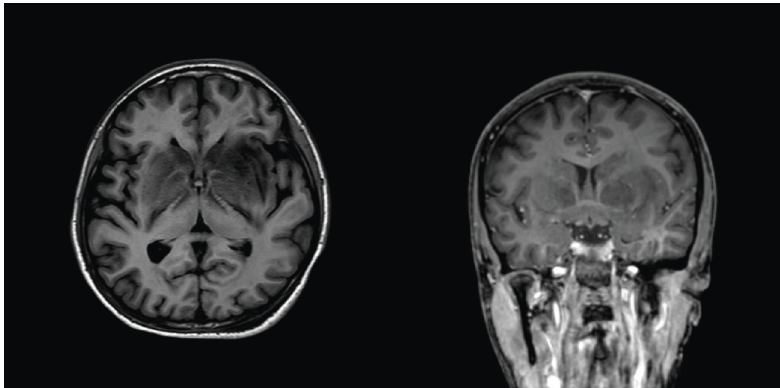
Figure 6: T1-W, an axial section and T1-W gadolinium contrast, a coronal section images at basal ganglia.